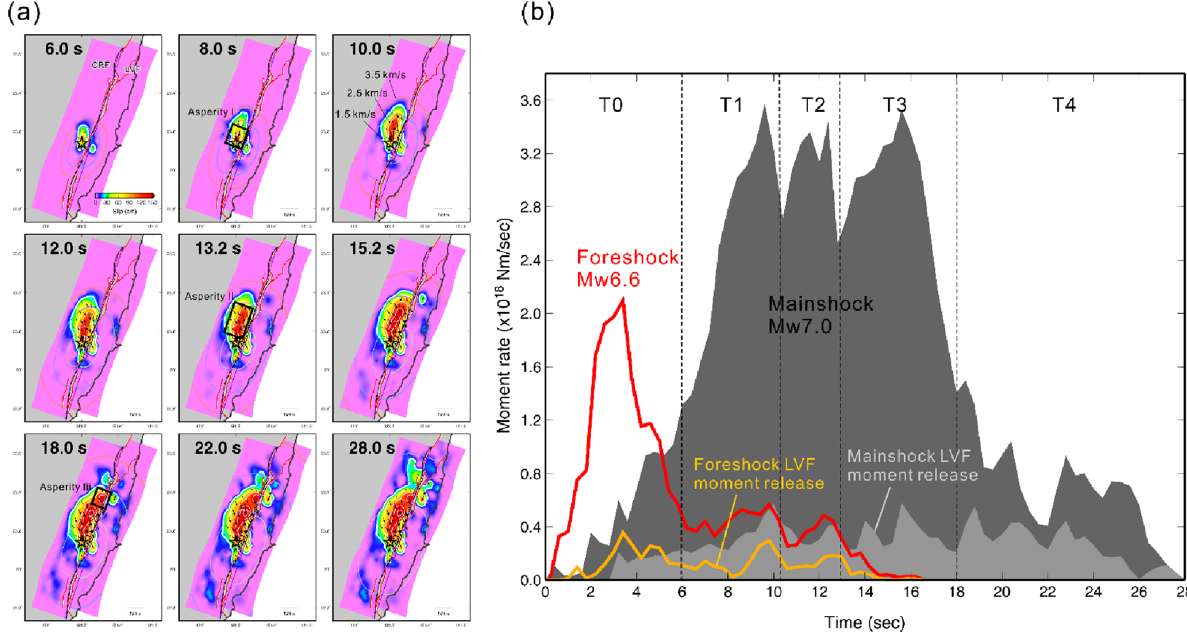
Figure 3. Rupture time history of the mainshock. ( a ) Rupture snapshots of the 0918 mainshock. Three reference rupture fronts with constant rupture speed Vr = 3.5, 2.5, and 1.5 km/s are shown with pink, blue and gray contours, respectively. Black rectangular indicates the three asperities. ( b ) The moment rate functions. The dark gray area shows the total moment release time history of the mainshock, and the light gray area indicates the moment released from the LVF. The moment rate function of the foreshock is shown with the red line, and the yellow line indicates the moment released from LVF. Five time intervals of the seismic moment releases are marked with T0, T1, T2, T3, and